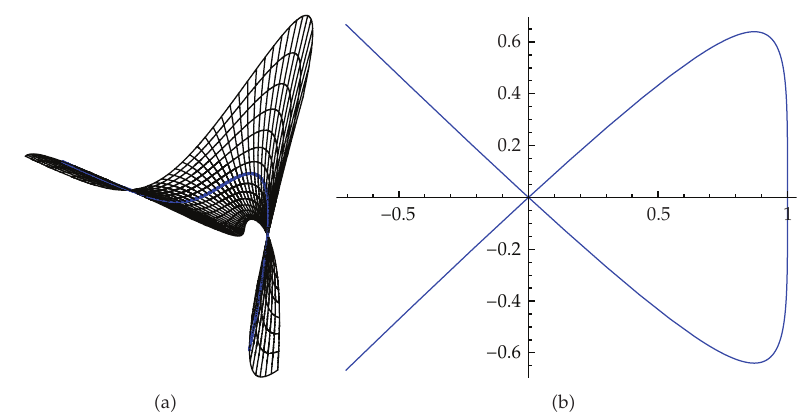
Figure 7: A timelike surface obtained by pseudo-Euclidean rotations parametrized by the Tchebychev net and the projection of a parametric curve onto yz -plane.